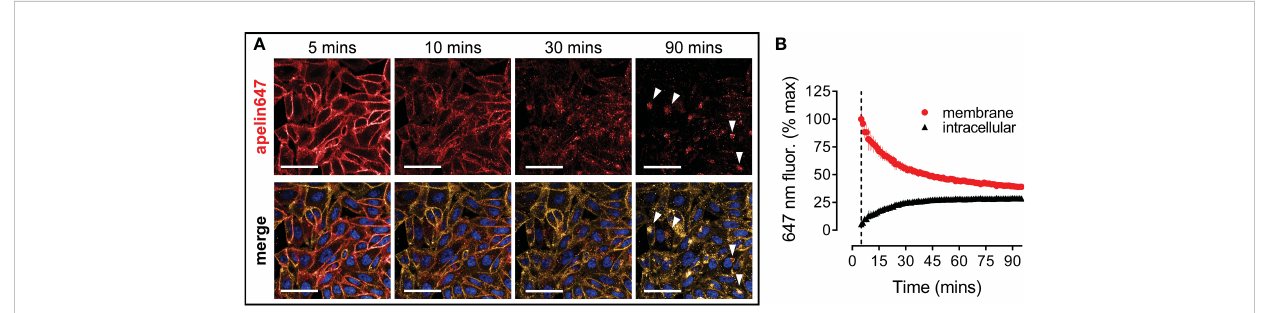
FIGURE 4 Apelin647 induces apelin receptor internalisation that can be visualised using high content imaging. (A) Representative confocal fl uorescent images of CHO-APLNR cells treated with 300 nM apelin647 over a 90 minute time-course (imaging commenced at 5 mins). Bottom row shows a merge with wheat-germ agglutinin-555 membrane marker (visualised in gold) and Hoechst 33342 nuclear marker (visualised in blue). White arrows indicate perinuclear staining. Scale bars indicate 50 µm. n = 3 independent experiments. (B) Quanti fi ed membrane ( ● ) and intracellular ( ▲ ) localisation of apelin647 fl uorescence (expressed as % max membrane fl uorescence observed at time 5 mins) over the 90 minute time-course. Data are expressed as mean ± s.e.m., pooled from n = 3 independent